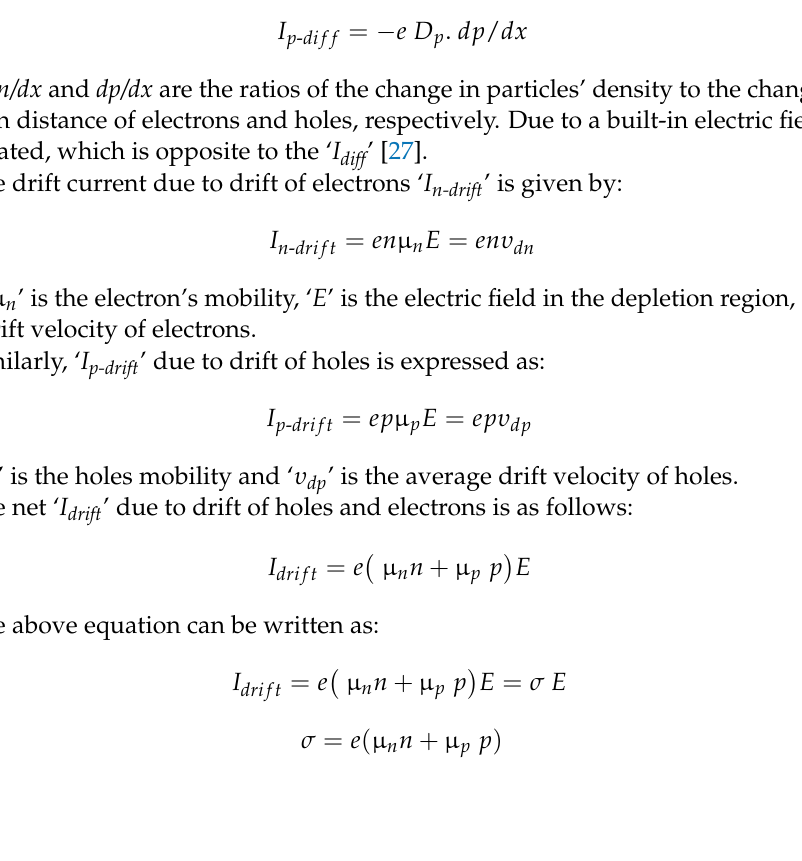
Figure 4. The flow of majority carriers in a forward-biased diode.